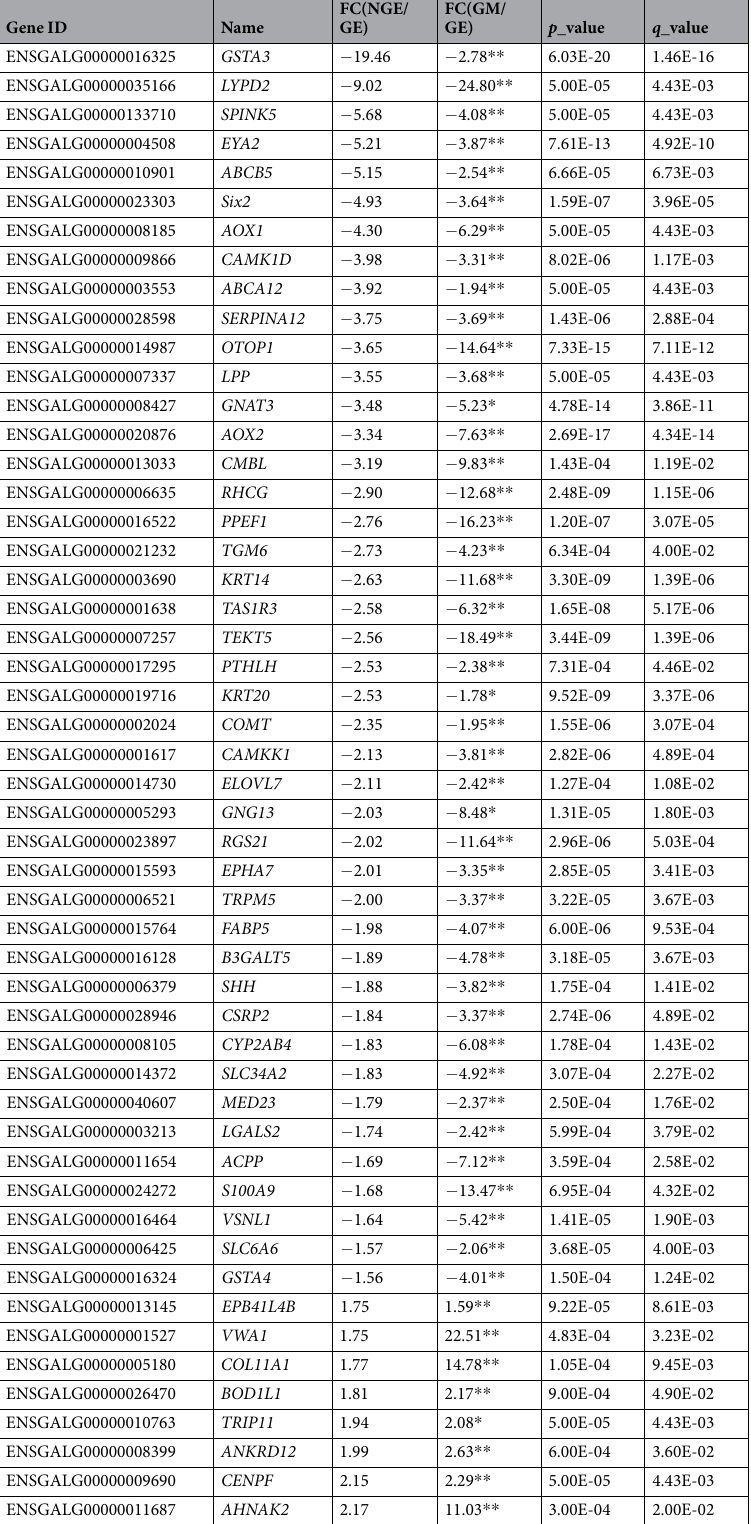
Table 3. Fifty-one highly (43) or lowly (8) expressed transcripts in the GE compared to both NGE and